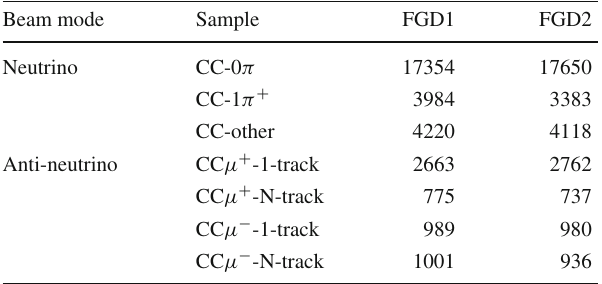
Table 14 The number of observed events for ND280 samples in neu- trino and anti-neutrino beam modes